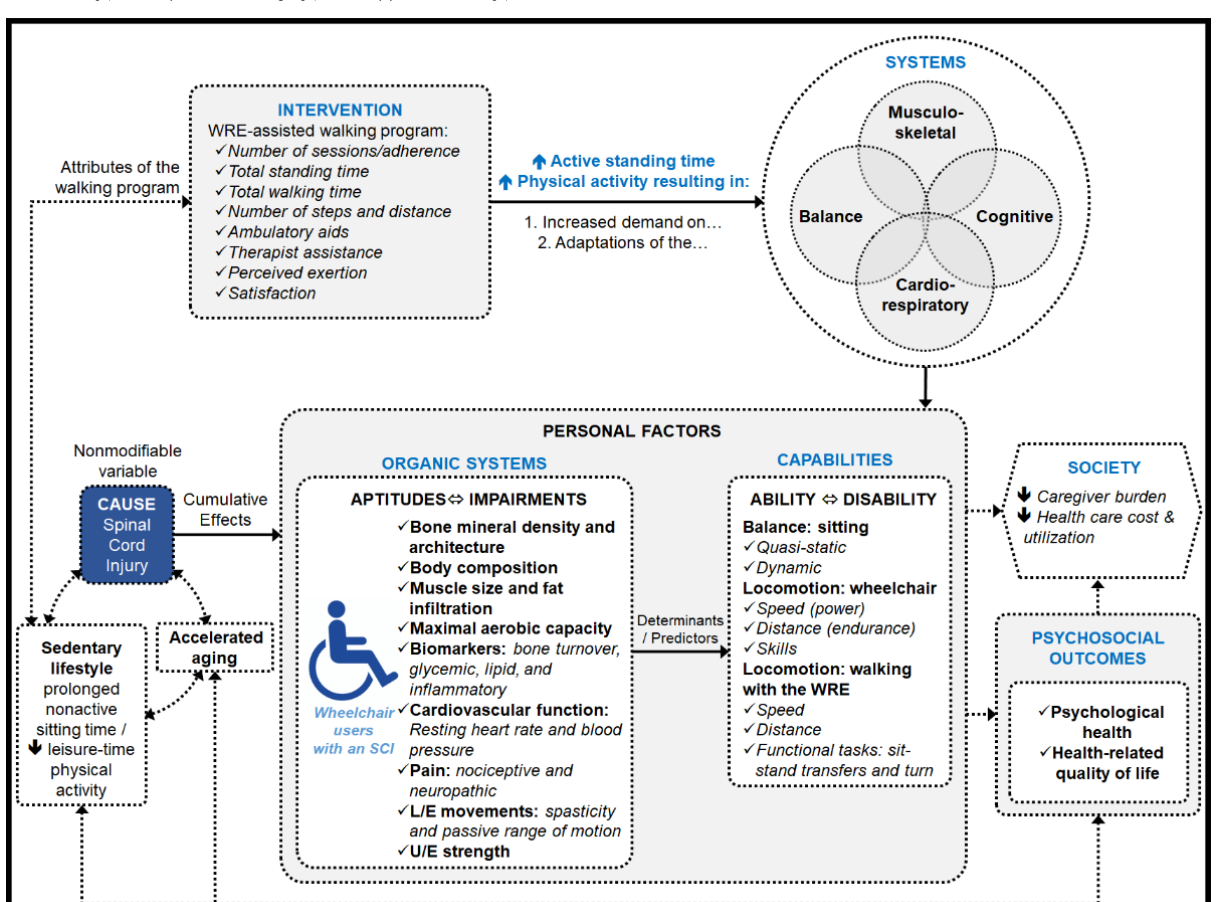
Figure 4. Project-specific logic model highlighting the relationships between the different domains of interest and related outcome measures. L/E: lower extremity; SCI: spinal cord injury; U/E: upper extremity; WRE: wearable robotic